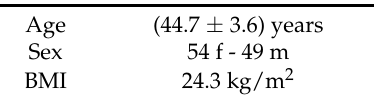
Table 1. Demographic data all participants.